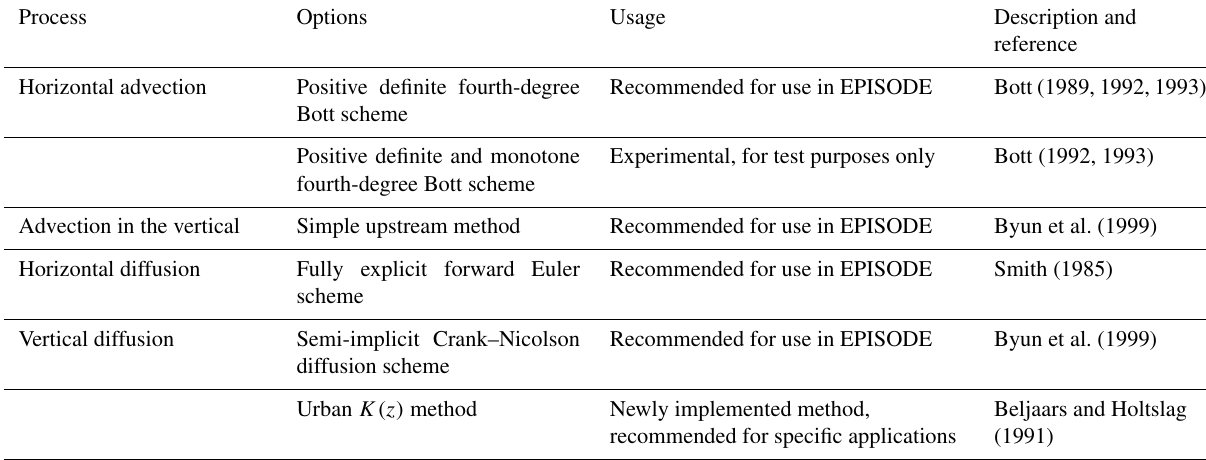
Table 1. A compilation of all of the possible 3D advection and diffusion schemes usable for the EPISODE Eulerian grid transport. Process